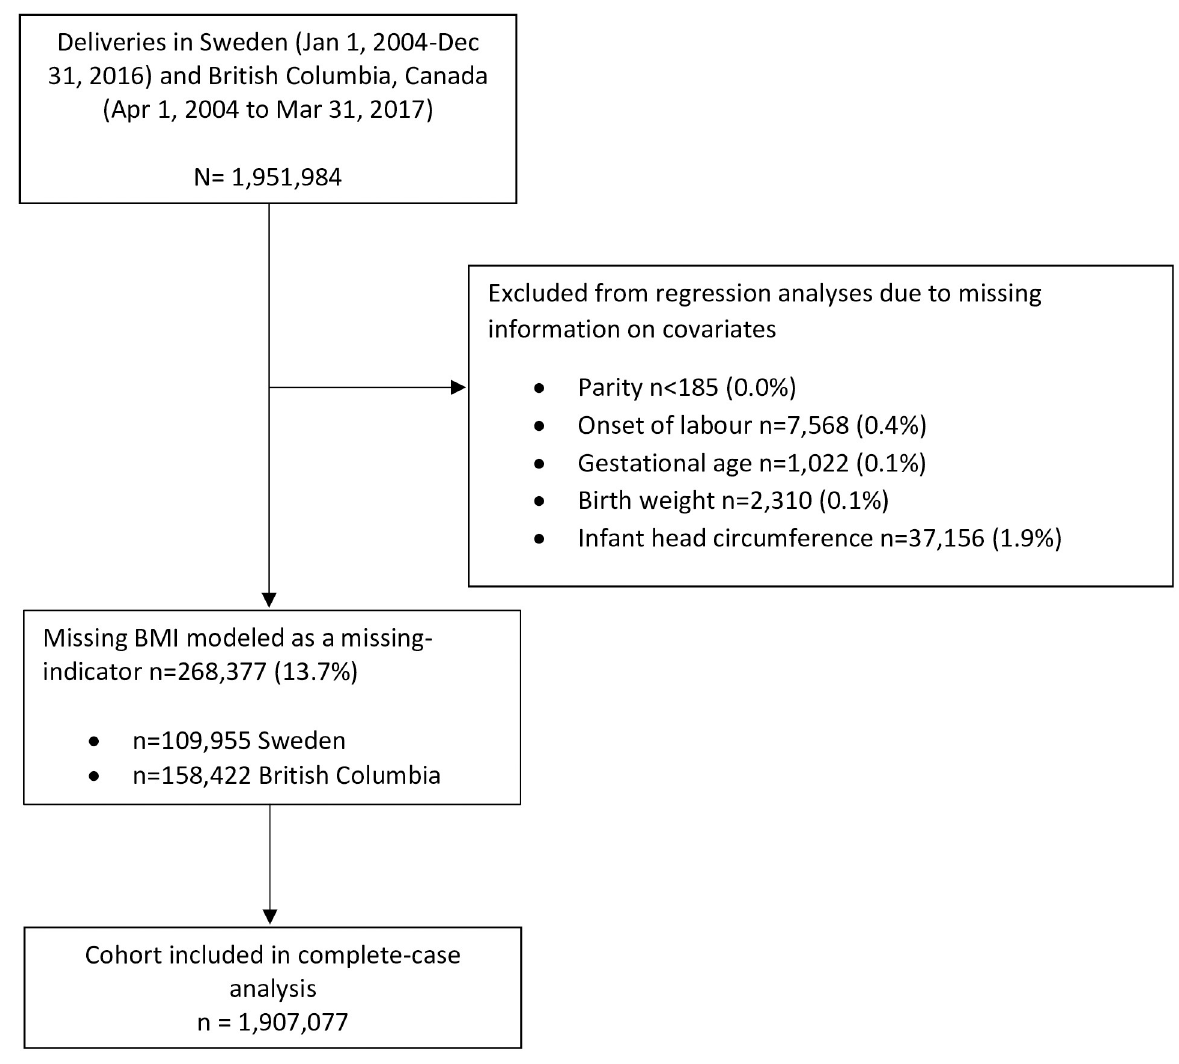
Fig 1. Flow diagram showing derivation of